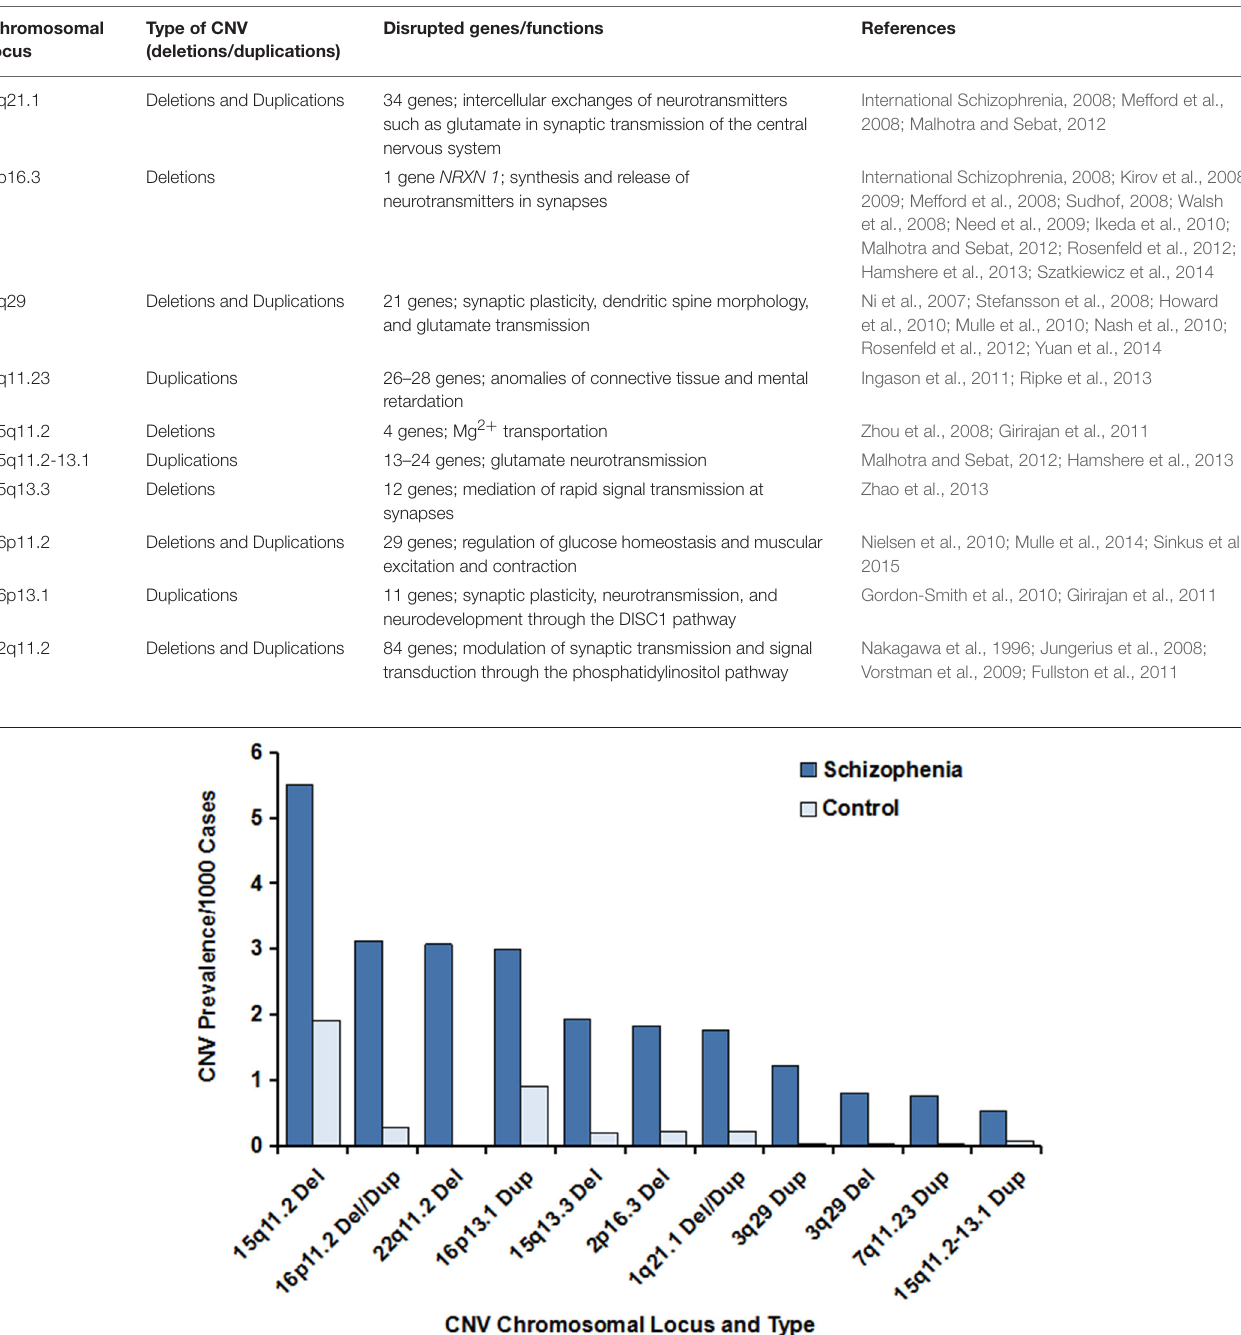
TABLE 1 | Major susceptibility CNVs for schizophrenia.